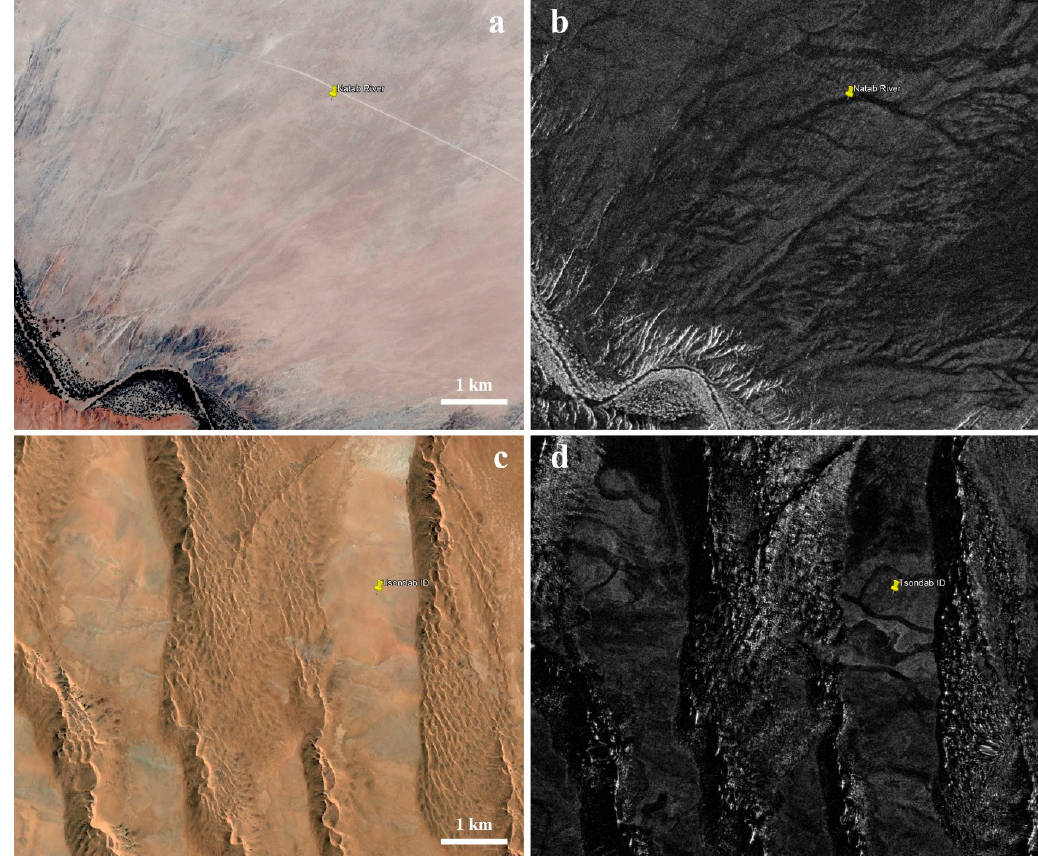
Figure 2. Landsat-7 image ( a ) and PALSAR-2 radar image ( b ) of the Natab River study site. Landsat-7 image ( c ) and PALSAR-2 radar image ( d ) of the Tsondab ID study